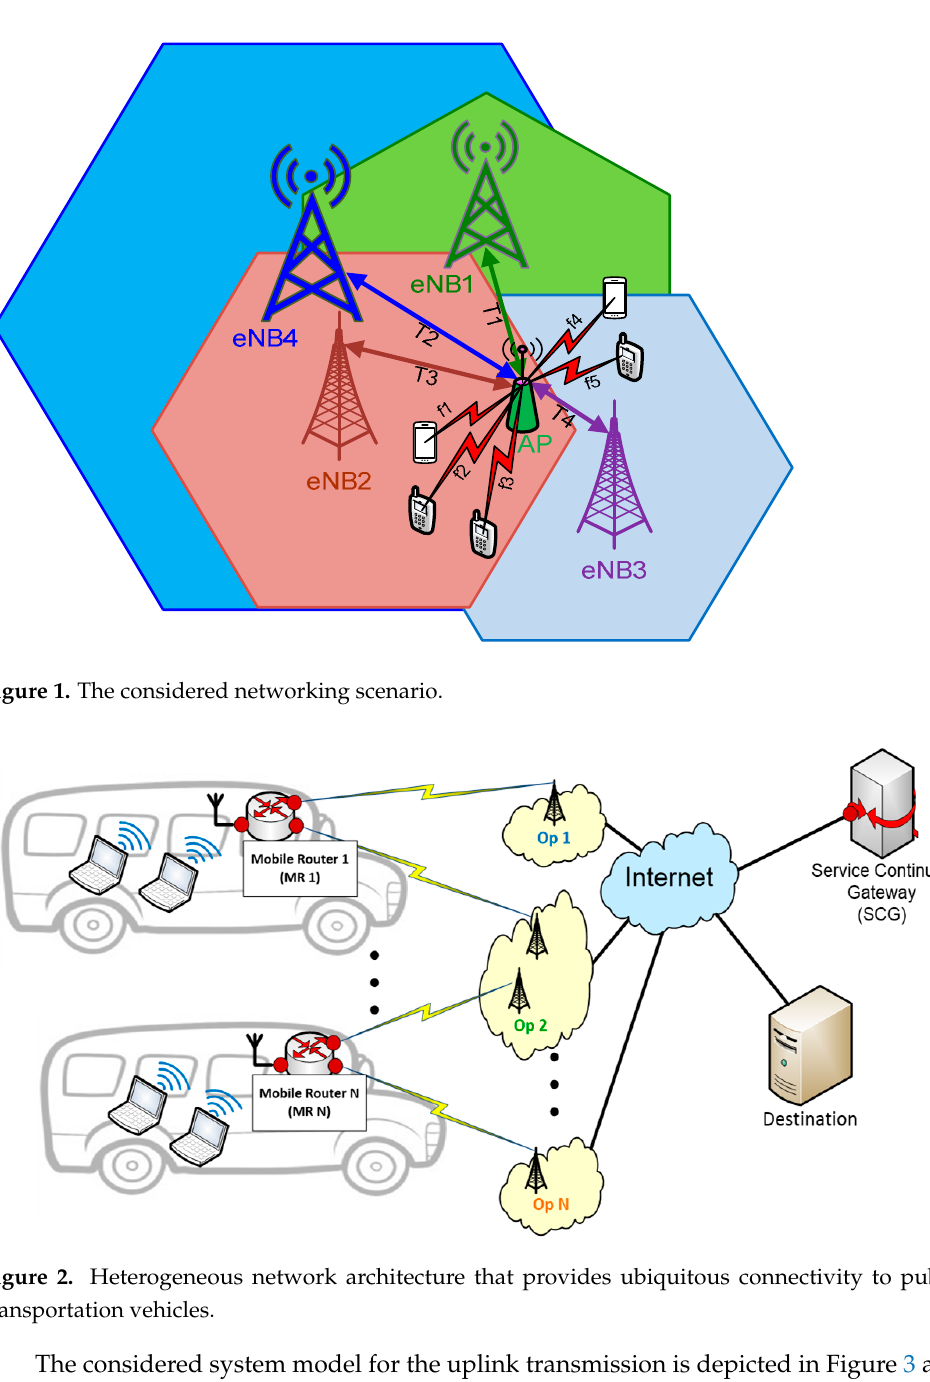
Figure 1. The considered networking scenario.